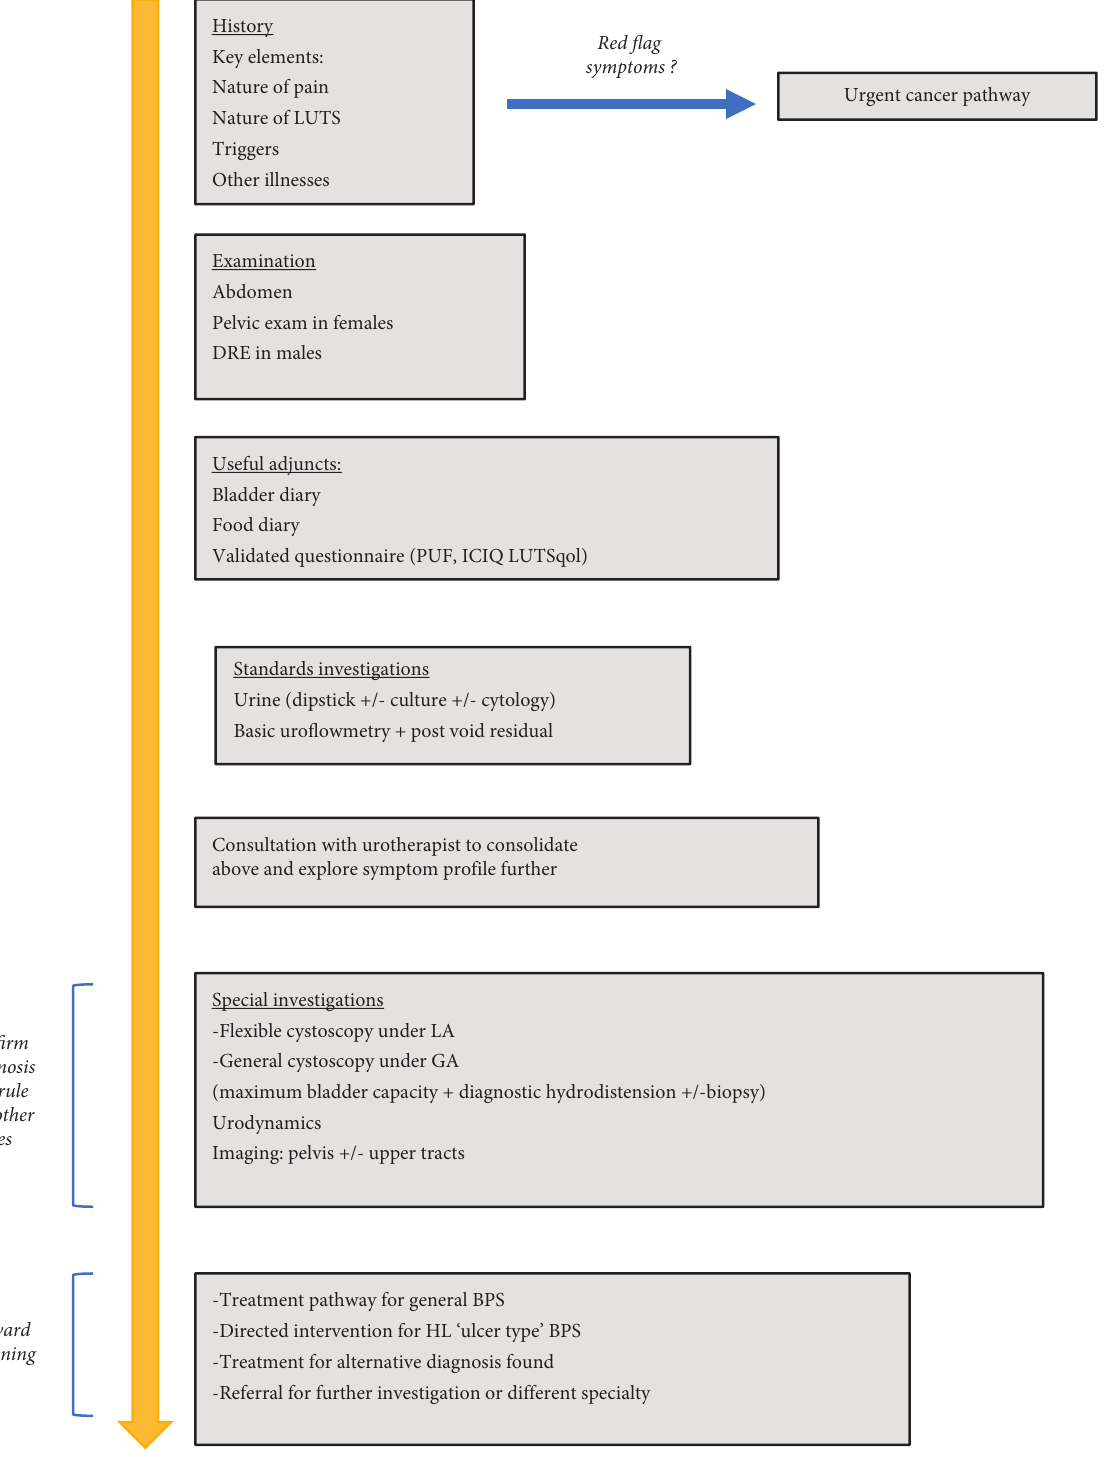
Figure 1: Diagnostic pathway for